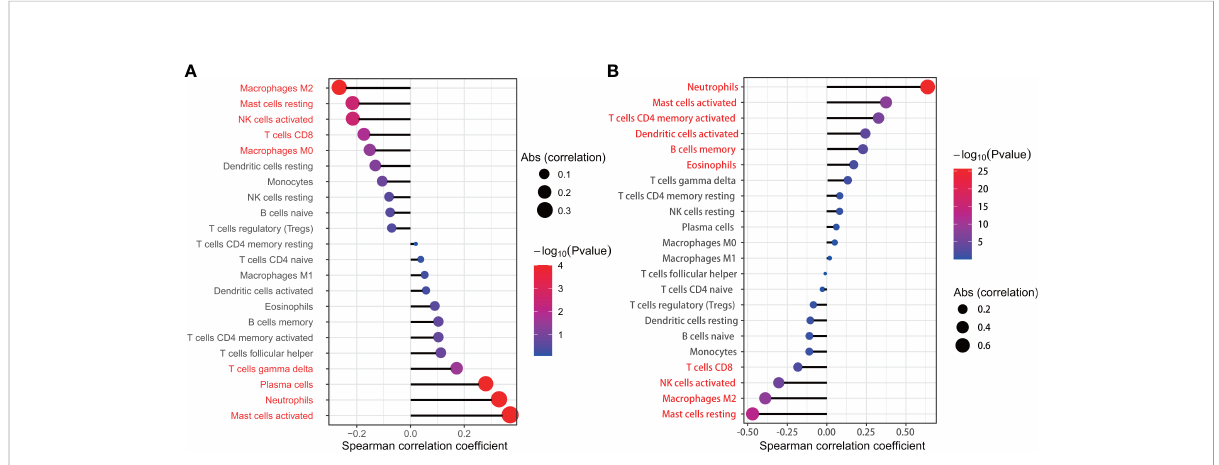
FIGURE 10 The relationship between SERPINA3 (A), IL1R2 (B) and the in fi ltration level of lung tissue-in fi ltrating immune cells; Statistical signi fi cance (P<0.05) in red